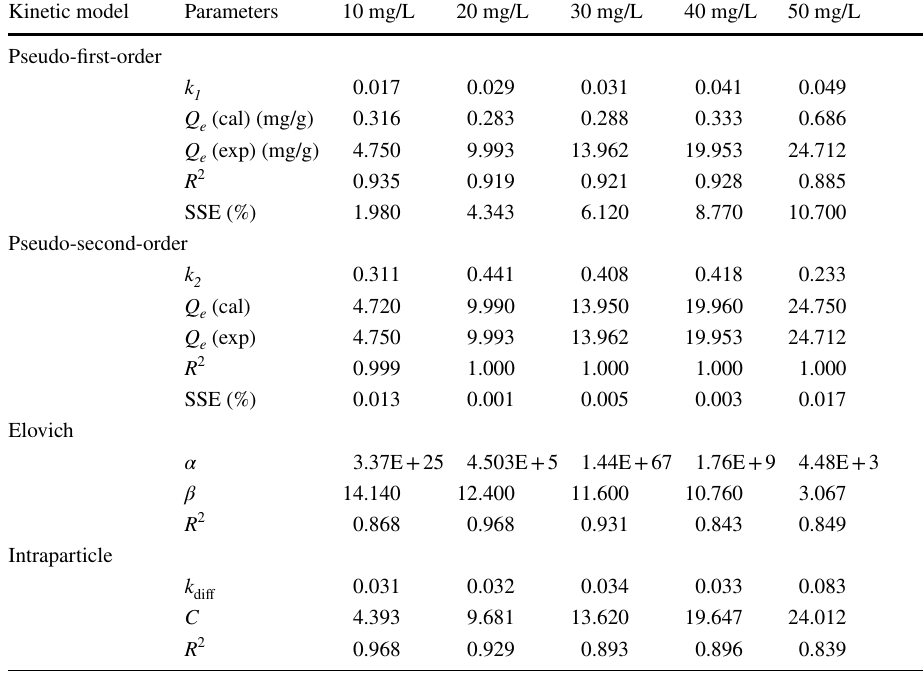
Table 5 Pseudo-first-order, pseudo-second-order Elovich and intraparticle diffusion model parameters for ibuprofen adsorption onto OPA at 30 °C